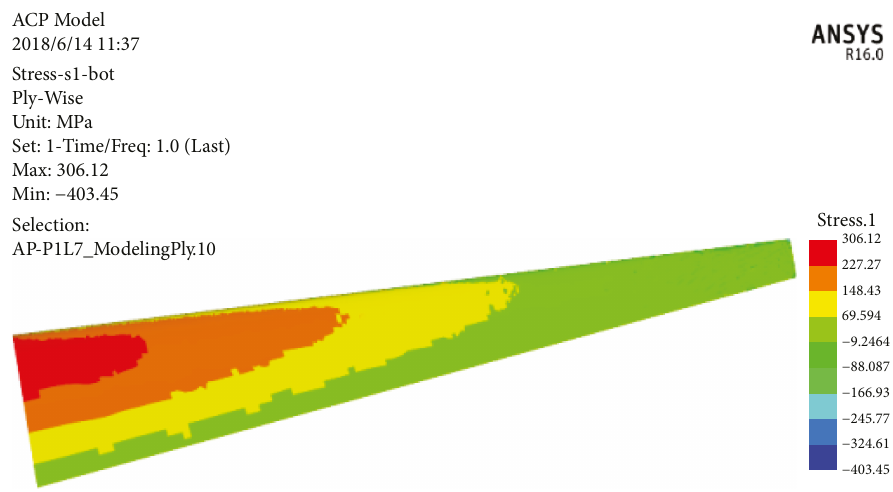
Figure 63: Stress cloud diagram of the lower wing with full composite. Table 9: Structural performance of di ff erent